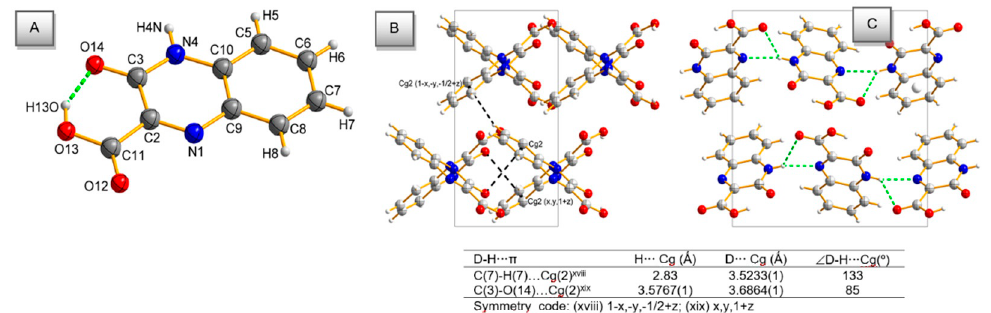
Figure 5. Molecular structure of L 2 2, with the atom numbering scheme and with marked intramolecular H-bond ( A ); ( B ) the infinitive ribbon motive formed by the N-H ··· N and N-H ··· O hydrogen bonds; ( C ) the fragment of alternating chains and the geometry of the C-H ··· π and C-O ··· π interactions (Cg(2): 6-membered ring defined by C(5), C(6), C(7), C(8), C(9), and C(10) atoms).